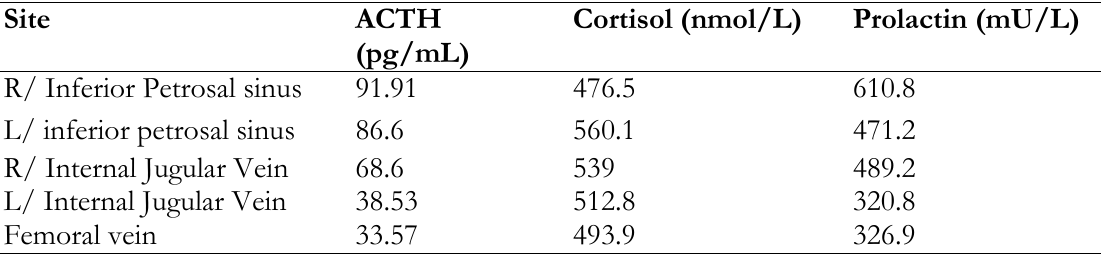
Table 1. Results of inferior petrosal sinus